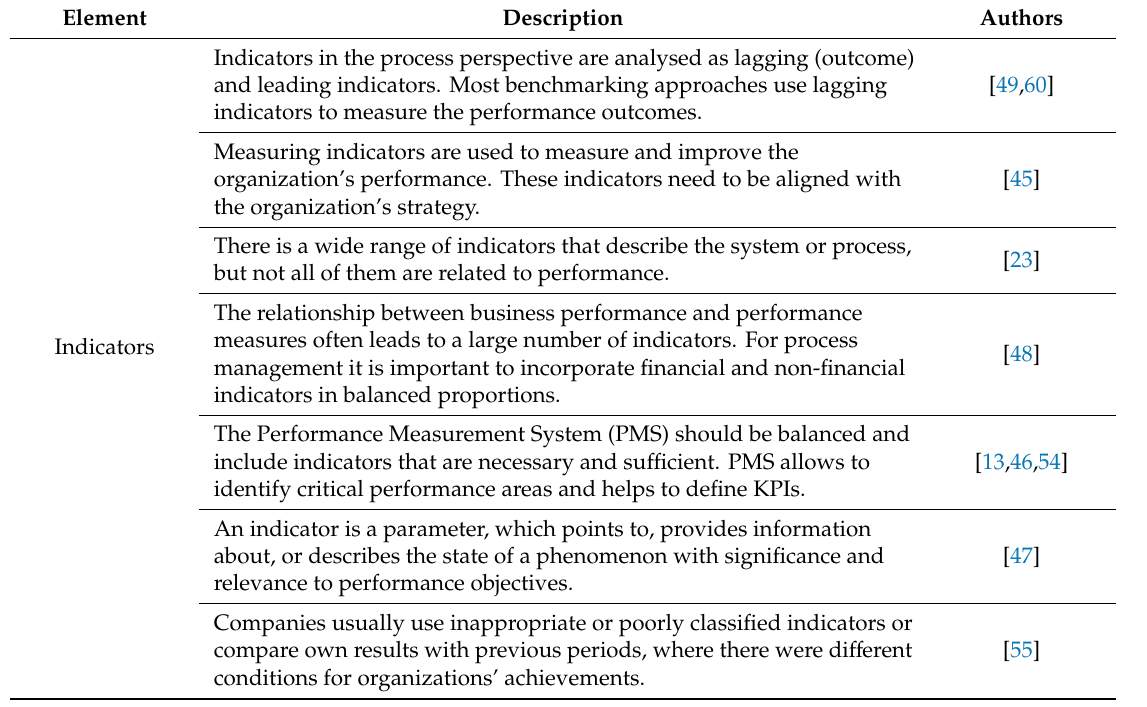
Table 4. The term, indicators, used in relation to organizational